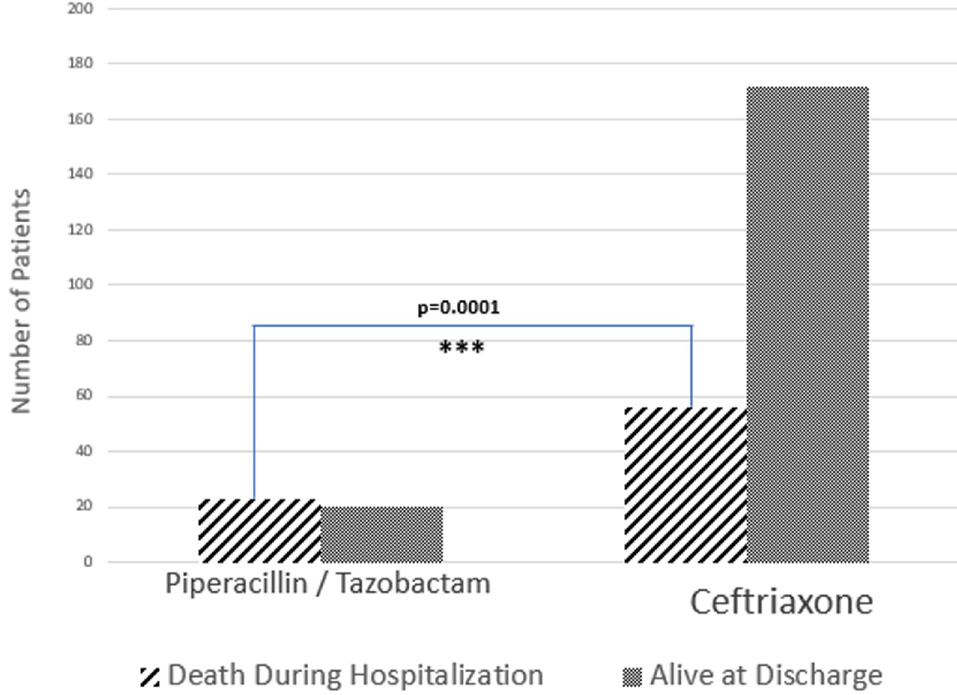
Fig 2. First line antibiotic choice. Using Piperacillin/Tazobactam as the first line agent leads to statistically worsened mortality (p = 0.0001). https://doi.org/10.1371/journal.pone.0239470.g002 associated with a change in mortality (p = 0.16). Use of piperacillin-tazobactam was associated with higher mortality (29.1% compared to 10.4%, p = 0.0001, Fig 2), transfer to an ICU (62.0%